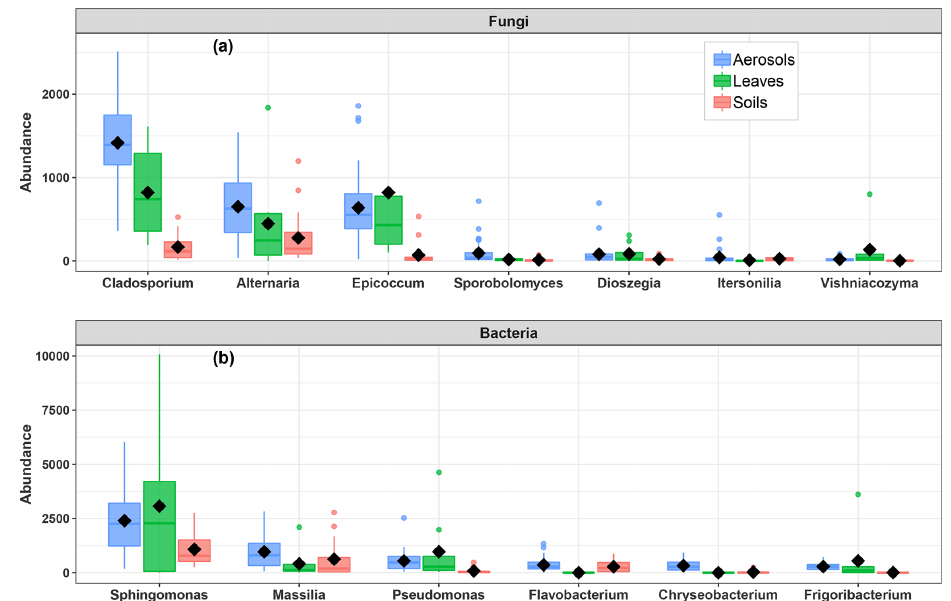
Figure 6. Abundance of SC-species-associated microbial taxa. (a) Fungal genera and (b) bacterial genera in the airborne PM 10 samples and surrounding environmental samples. Black markers inside each box indicate the mean abundance value, while the top, middle, and bottom lines of the box represent the 75th, median, and 25th percentiles, respectively. The whiskers at the top and bottom of the box extend from the 95th to the 5th percentiles. Data were rarefied at the same minimum sequencing depth.